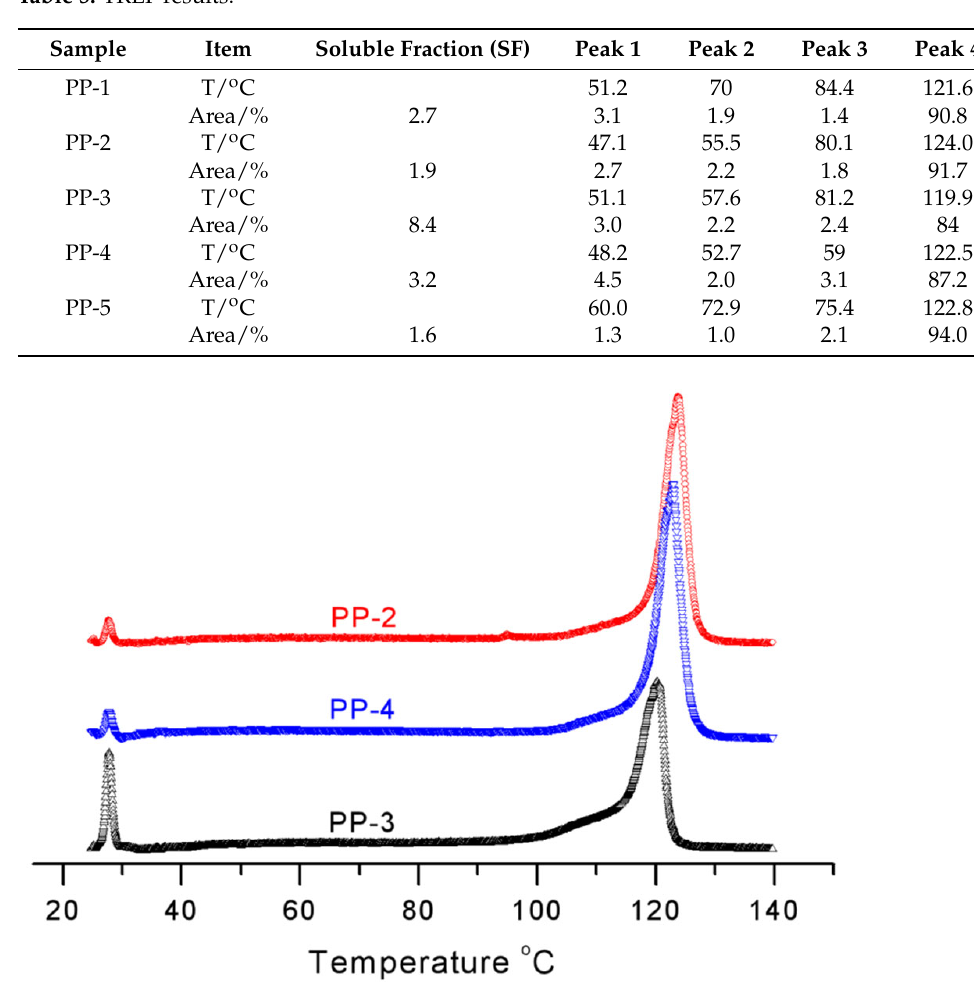
Figure 7. TREF results of the obtained PPs from cat-2/3/4. On the basis of 13 CNMR analysis, sequence distributions of methyl can be determined by its chemical shift from about 19.5 ppm to 22.0 ppm, and the calculation method of pentad sequence distribution is given in the supplemental information. From Figure 8, 5 pentad sequences, including mmmm (around 21.5 ppm), mmmr (21.2 ppm), mmrr (20.7 ppm), mrmm (20.4 ppm) and rrrr (19.9 ppm) sequences, could be identified, and the calculation results of methyl sequence of PP-1/PP-2/PP-4 are presented in Table 6. PP-2 obtained more isotactic mmmm sequences and fewer atactic rrrr sequences than PP-4 and PP-1, which is in good agreement with previous